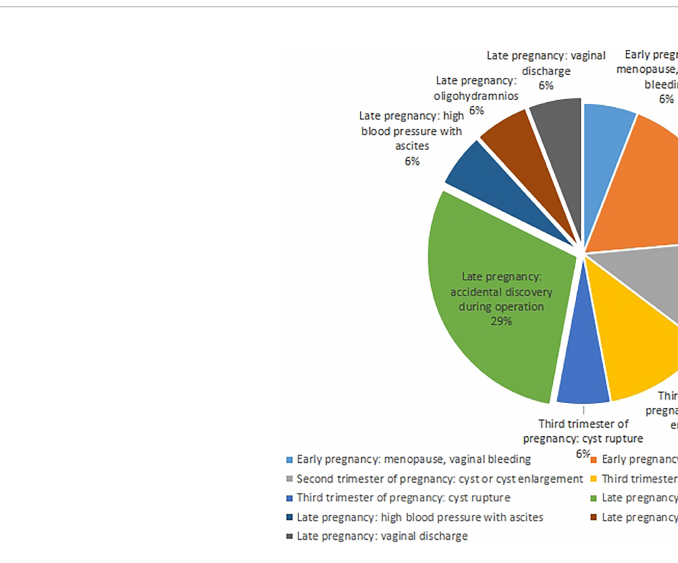
FIGURE 1 | Clinical manifestations of 17